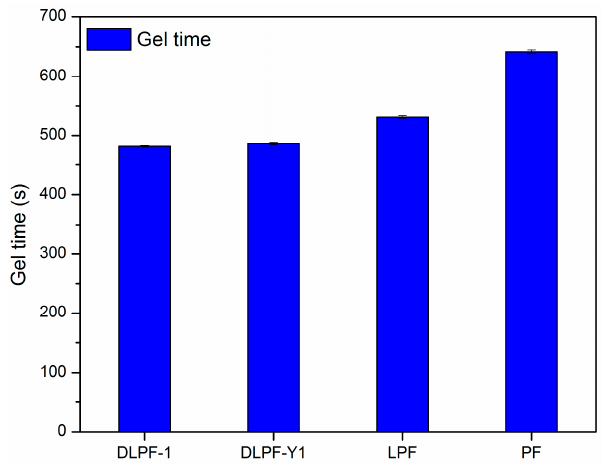
Figure 7. Gel time of PF, LPF, and DLPF resins.